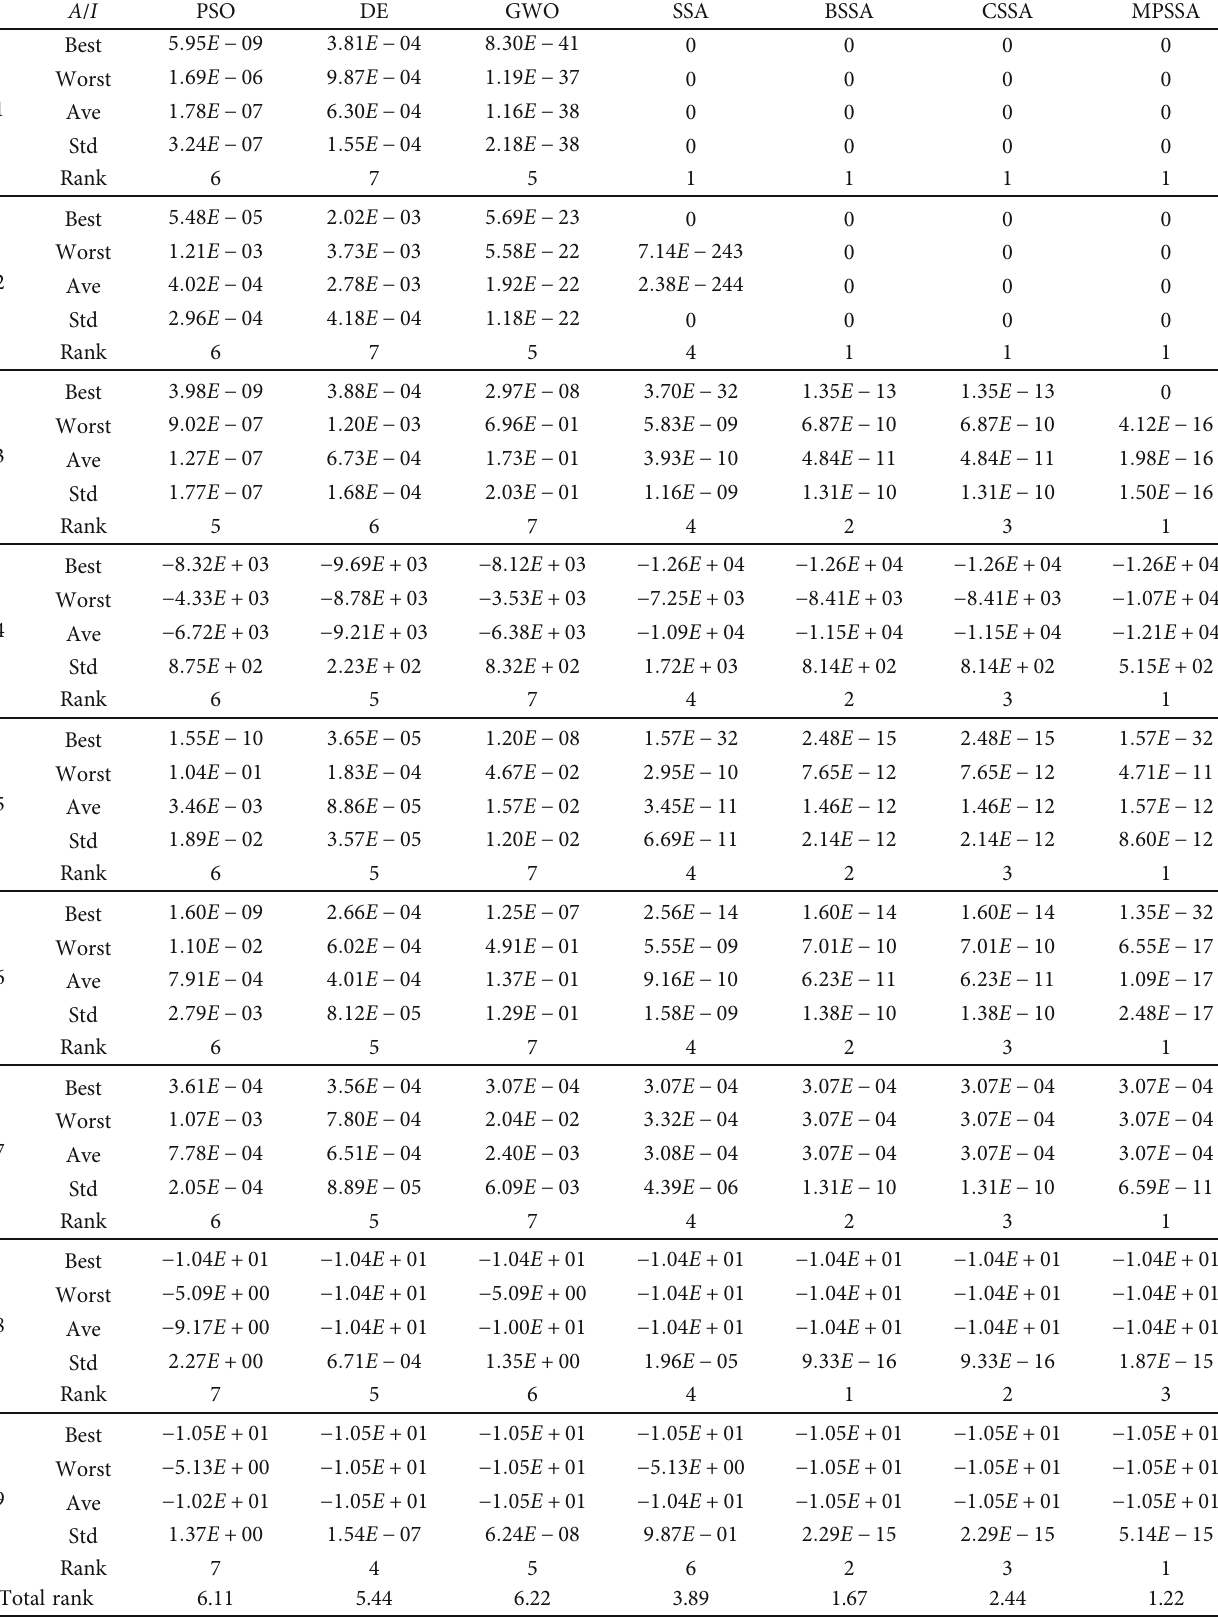
Table 3: Function experimental